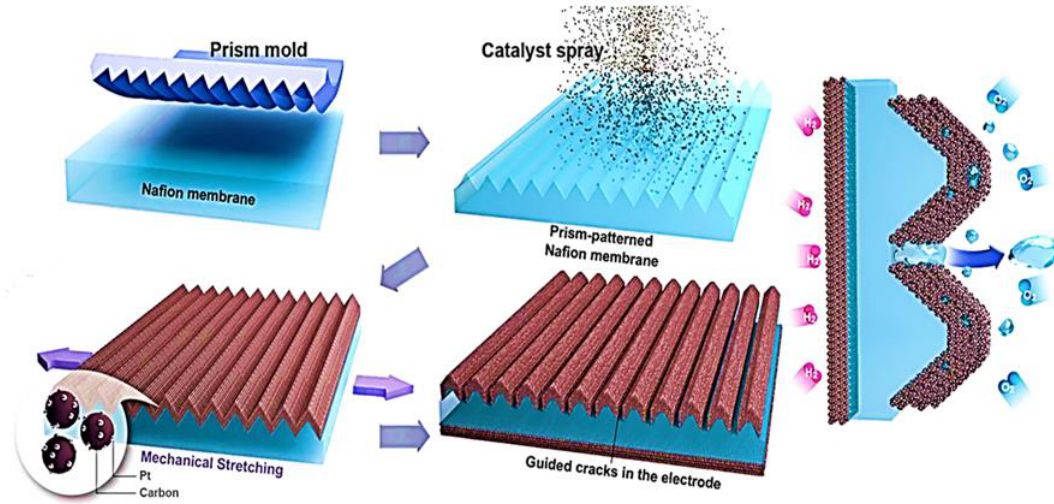
Figure 4. Schematic diagram of membrane electrode assembly [37] (open access).